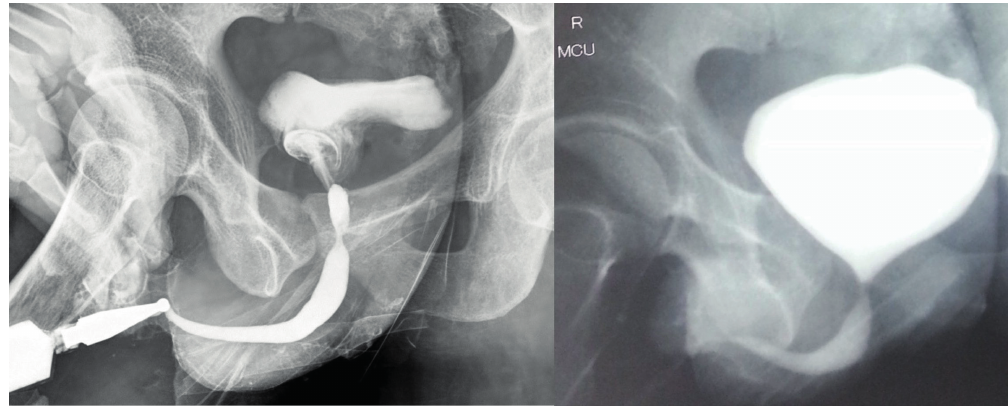
figure 3 - Ascending cysto-urethrogram and McU showing normal anterior urethra and a smooth walled small capacity bladder (which in retrospect was actually the prostatic utricle cyst).